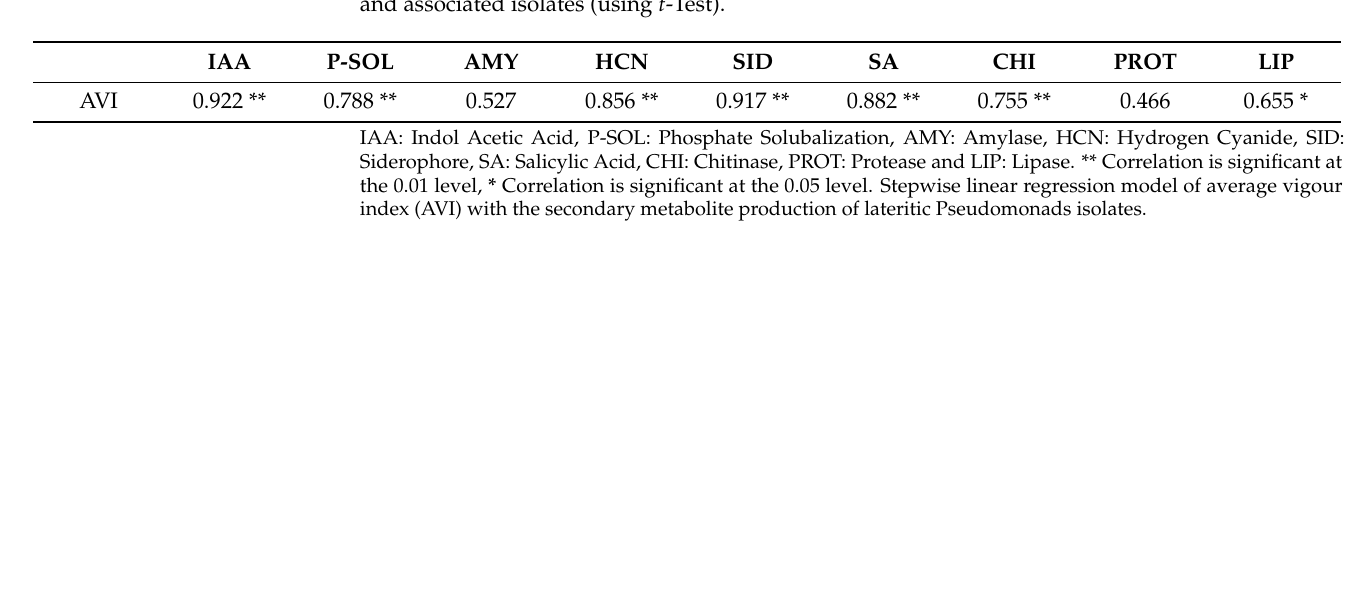
Table 6. Pearson correlation coefficients of the average vigour index (AVI) (dependent variable) with the producrion of various secondary metabolite (independent variables) of lateritic Pseudomonads and associated isolates (using t